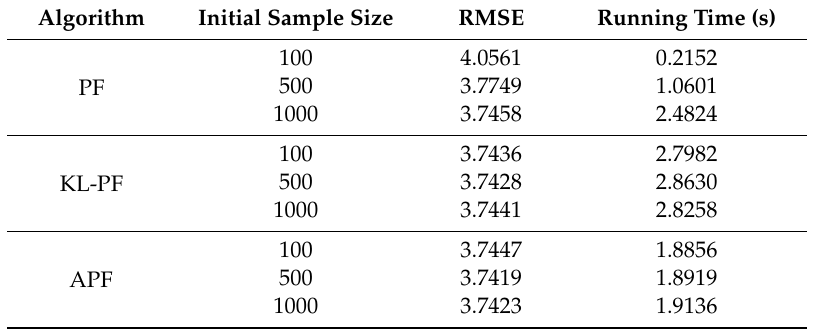
Table 1. Comparison of simulation results in the univariate non-static growth (UNGM) model.